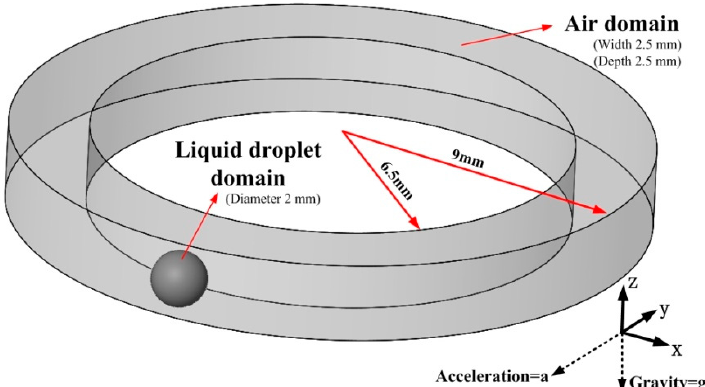
Figure 1. Schematic diagram of the 3D model. The outer and inner diameters of the groove are 18 mm and 13 mm, respectively. The direction of acceleration is in negative Y and gravity in negative Z.